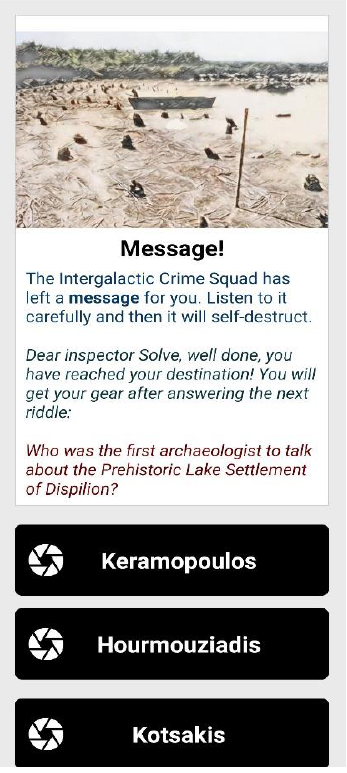
Figure 13. The player is prompted to answer a question in order to progress in the game.